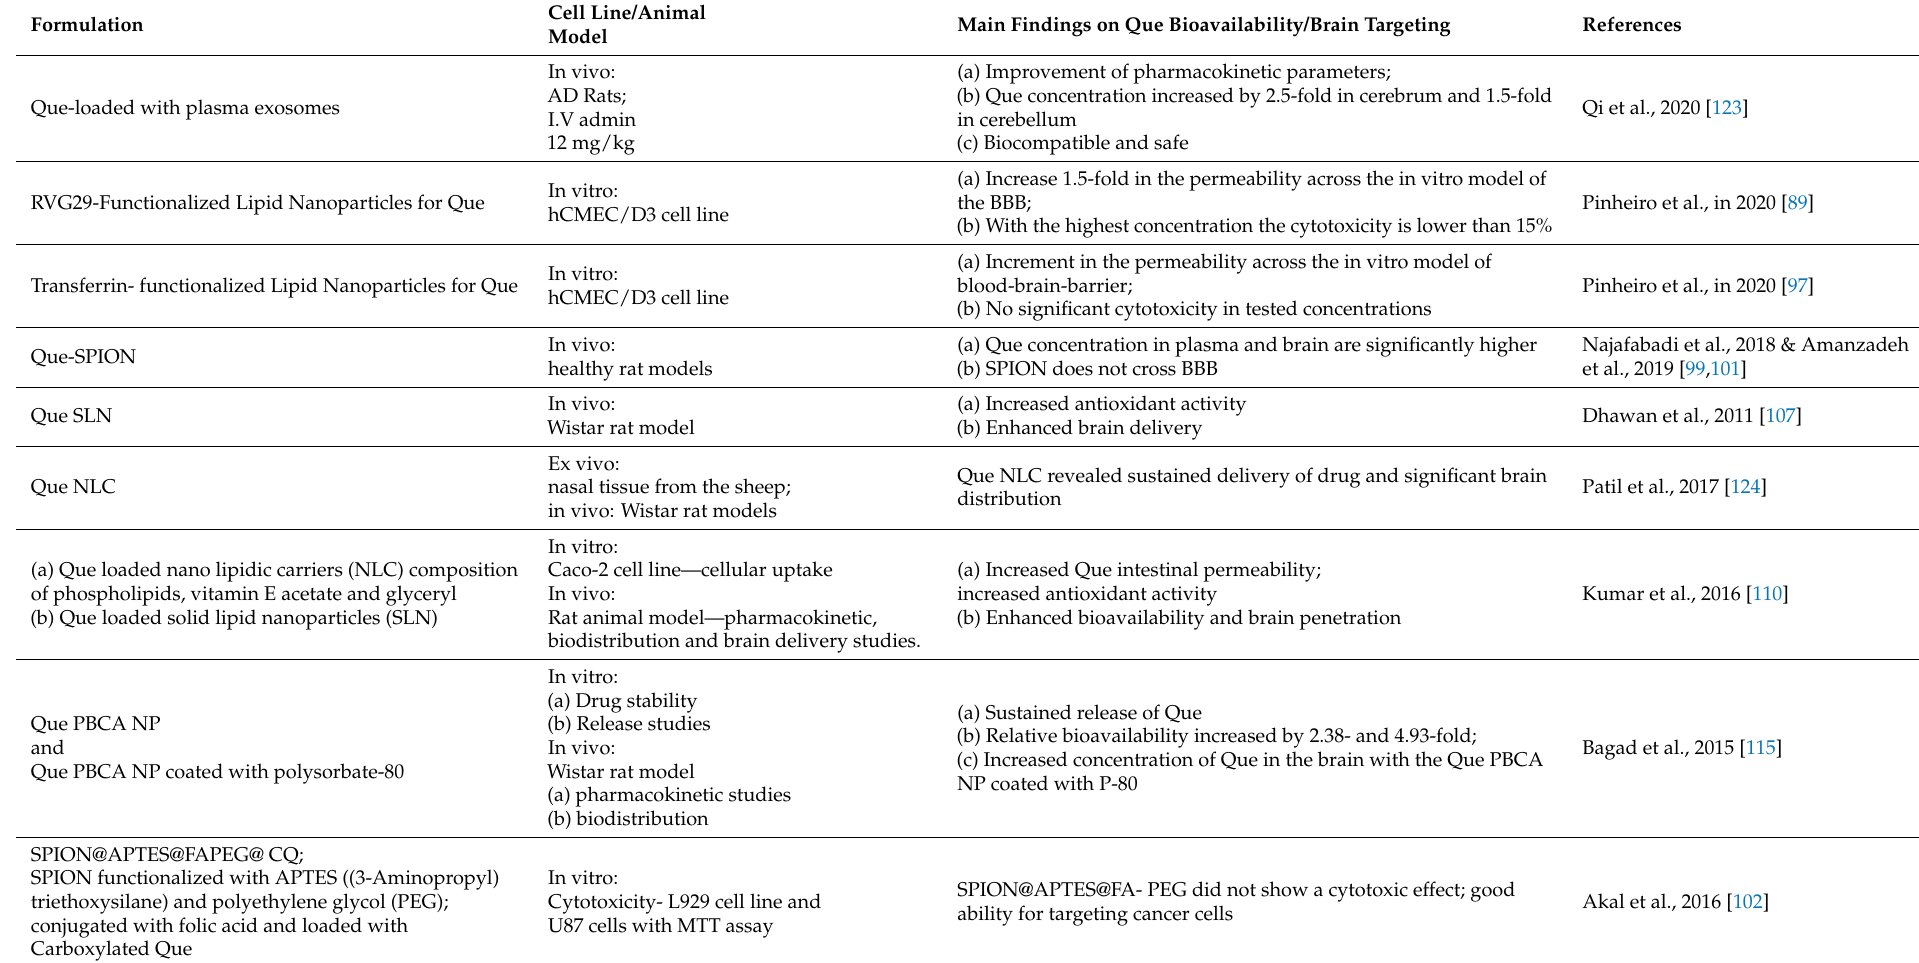
Table 2. Details of in vitro and animal studies of Novel formulations of Que and their effect on bioavailability and brain